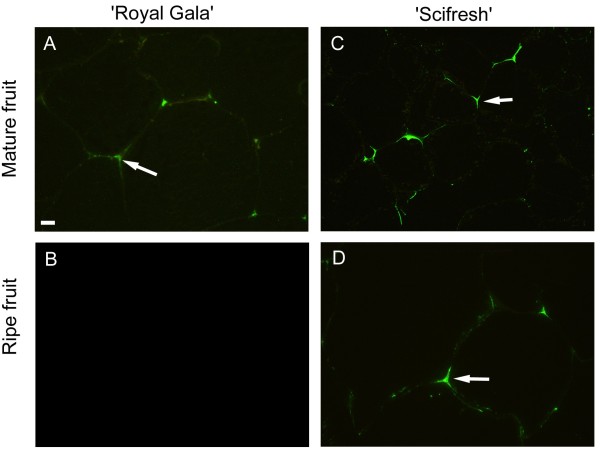
Immunofluorescence labelling for calcium-associated HG regions with antibody 2F4 in mature and ripe apple fruit. ‘Royal Gala’ (A, B) and ‘Scifresh’ (C, D) apple cortex tissue of mature fruit and ripe fruit. 2F4-labelling (green) was concentrated at tricellular junctions as indicated by the arrows. No labelling was detected in ripe ‘Royal Gala’ (B). Bar in (A) = 10 μm for all micrographs.